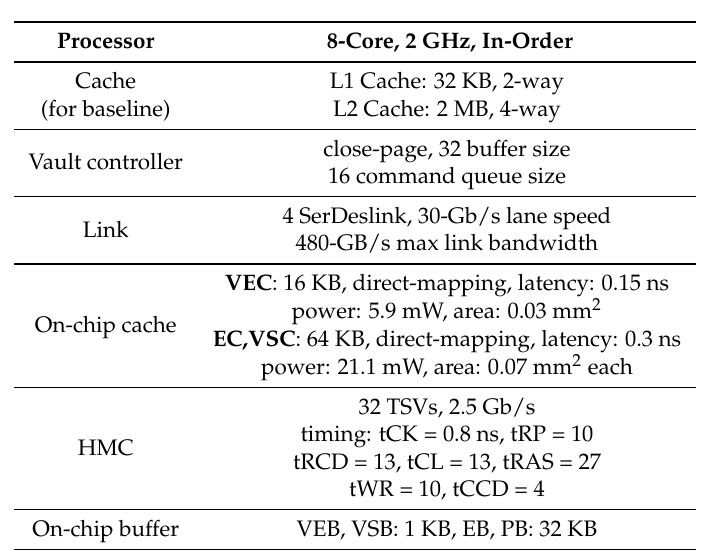
Table 3. System configuration. EC: Edge prefetch Cache; VEC: Vertex prefetch Cache; VSC: Visited prefetch